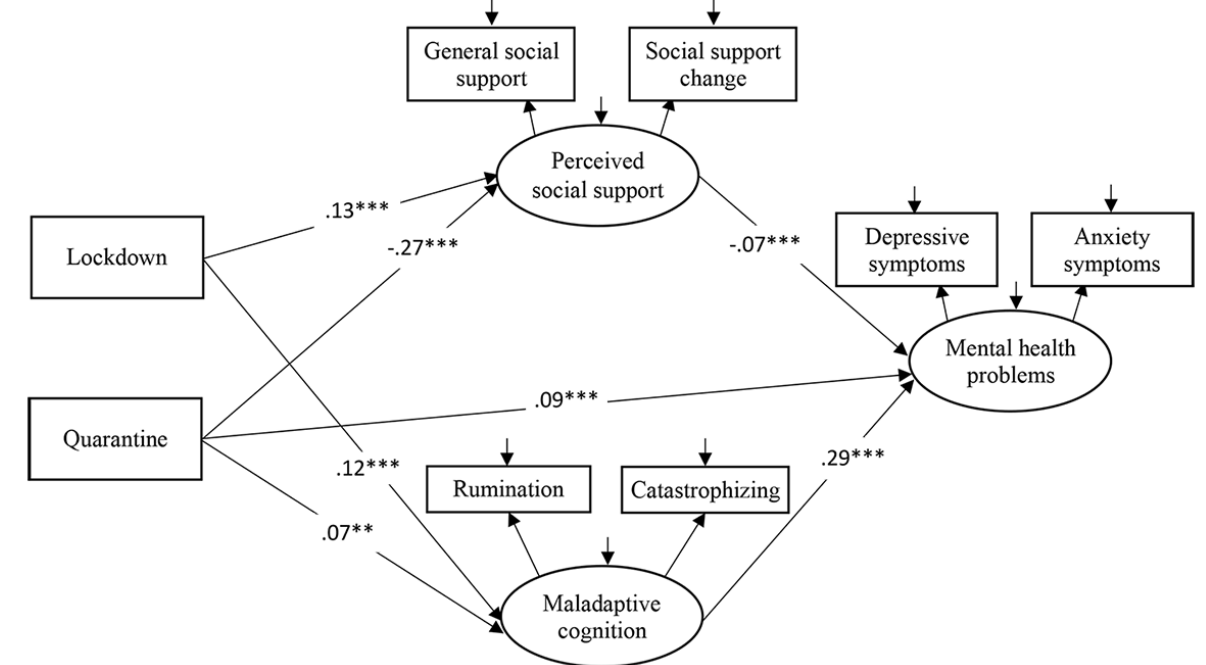
Figure 1. Proposed mediation model with unstandardized path coefficients. The nonsignificant path is not shown for simplicity reasons. * P <.05, ** P <.01, *** P